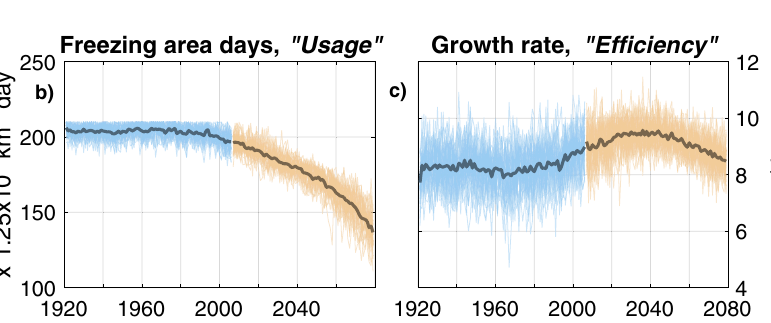
bydarkerlines.Notethatthefreezingareadaysisrescaledintermsofthetotalarea ofthestudyregion,suchthattheupperlimitis210onthey-axis:thedurationofour seven month winter period in